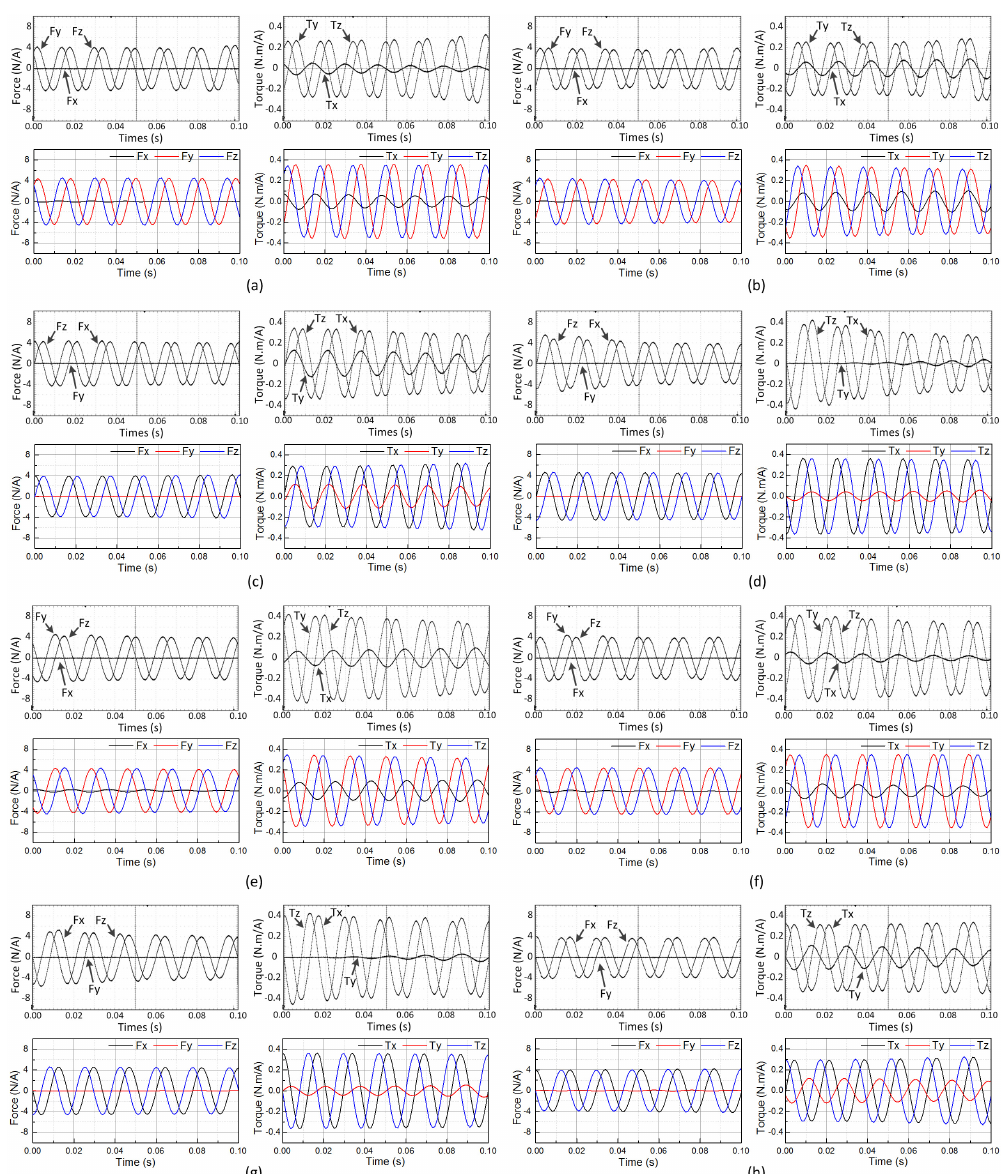
Figure 7. Waveform of real-time solutions on the oscilloscope ( up ) and boundary element method (BEM) solution obtained by Radia TM ( down ). ( a – h ) Results of Coil 0 ∼ Coil 7 ,